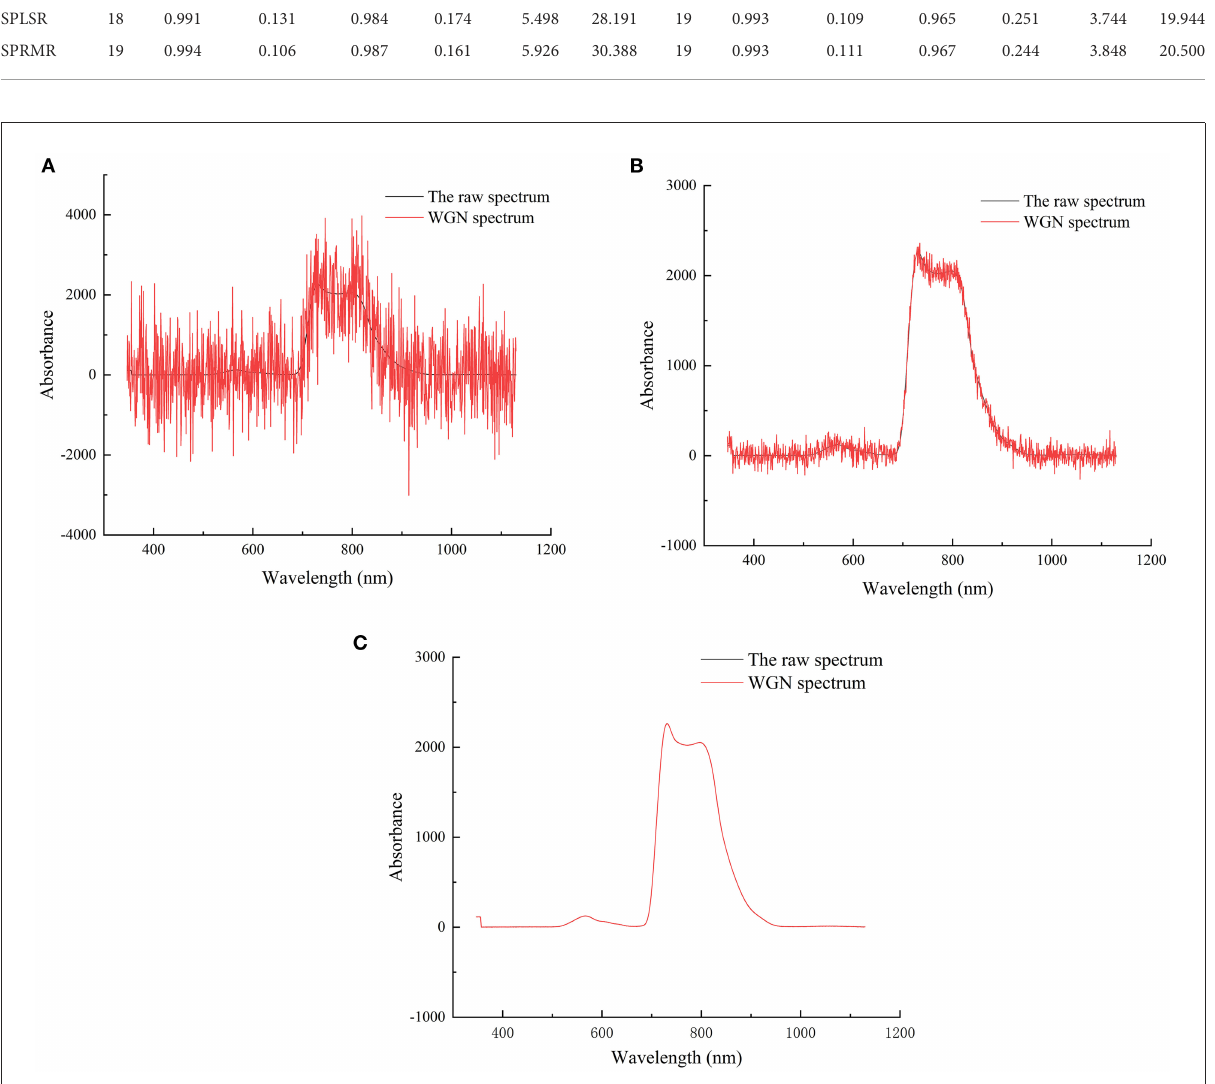
FIGURE4 (A) Spectra with − 10 SNR; (B) Spectra with 10 SNR; (C) Spectra with 50 SNR.